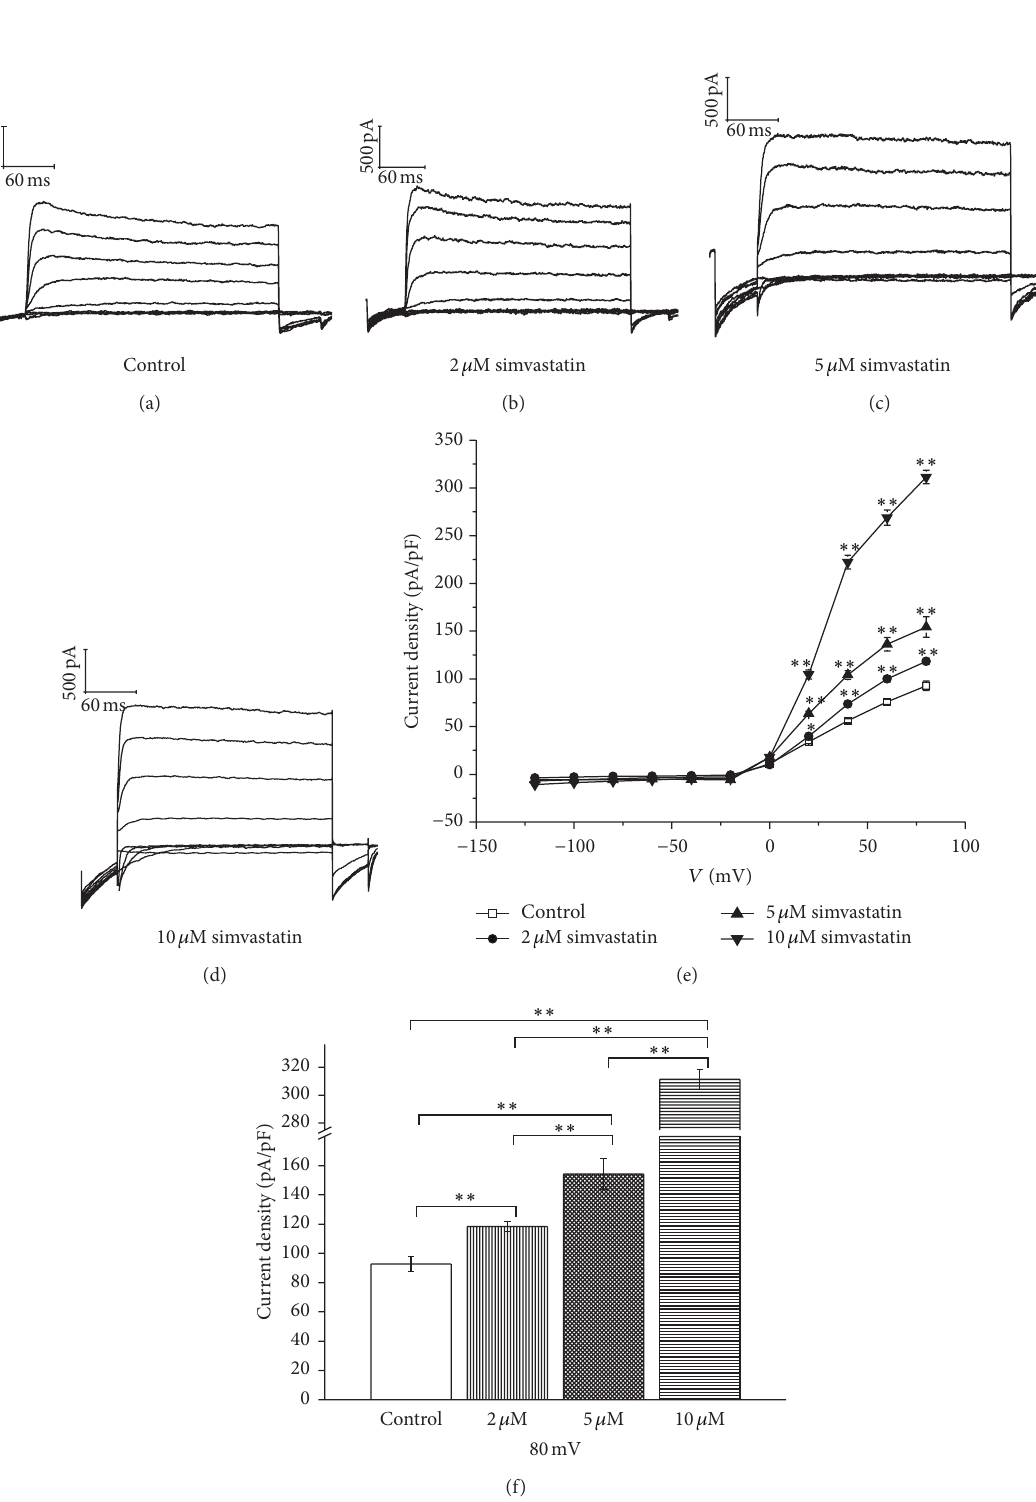
Figure 6: Effects of simvastatin on I KATP and current density in MIN6 cells ( ∗ 𝑃 < 0.05 , ∗∗ 𝑃 = 0.03 , and ∗∗∗ 𝑃 < 0.01 ). (a) KATP current of control group ( 𝑛 = 12 ), (b) KATP current with application of 2 𝜇 mol/L simvastatin ( 𝑛 = 12 ), (c) KATP current with application of 5 𝜇 mol/L simvastatin ( 𝑛 = 10 ), (d) KATP current with application of 10 𝜇 mol/L simvastatin ( 𝑛 = 8 ), (e) current density-voltage ( J - V ) curves of four groups, and (f) the current densities of cells with application of different concentrations of simvastatin at 80 mV